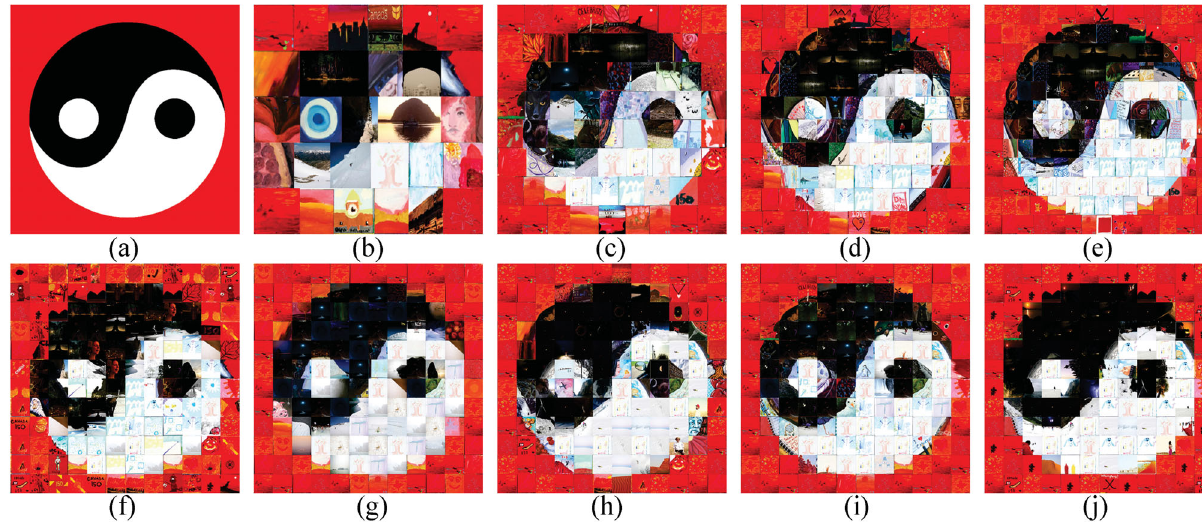
Fig. 6 Image mosaics for the tai chi diagram. (a) Target image. (b–e) Our results with 5, 8, 10, and 12 rows of tiles. (f) Result created by Foto-Mosaik-Edda. (g) Result with dense polynomial descriptor. (h) Result with sparse polynomial descriptor. (i) Result with dense grid descriptor. (j) Result with sparse grid descriptor. Images (f–j) have 12 rows of